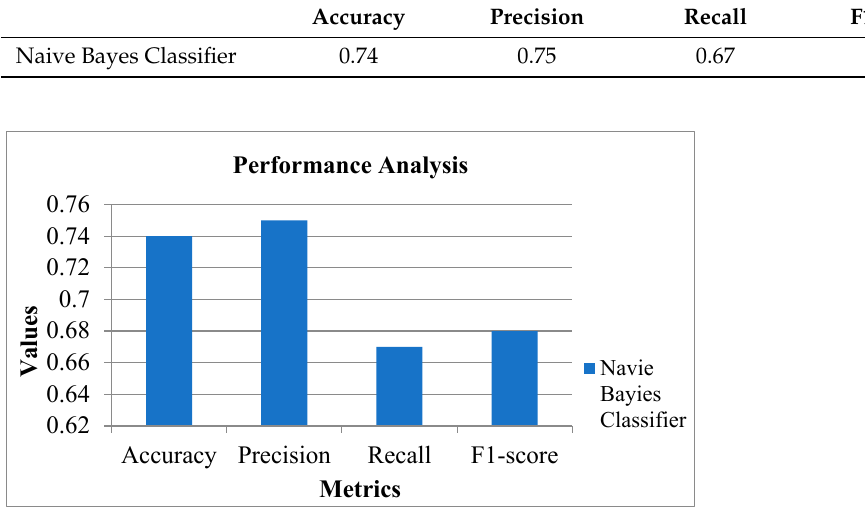
Figure 15. Performance Analysis of the NB classi fi er.